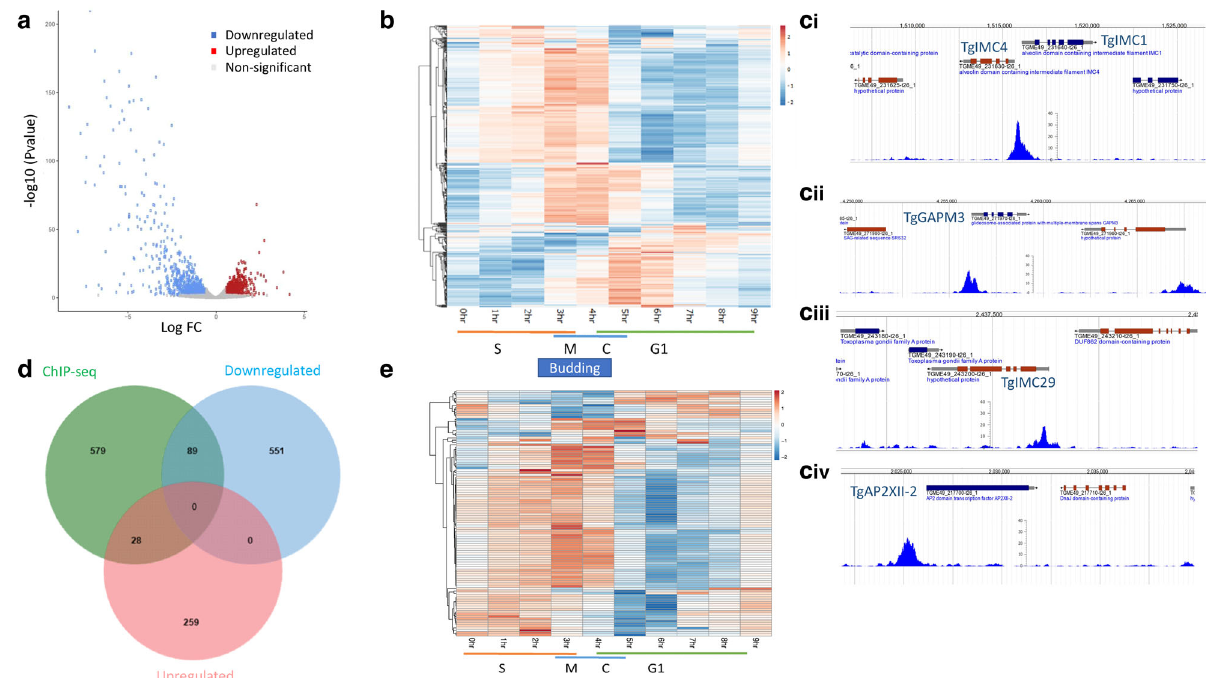
Fig. 5 TgAP2IX-5 controls the expression of key genes involved in daughter parasite formation. a Volcano plot of differentially expressed genes analyzed from RNA-sequencing of TgAP2IX-5 parasites treated with auxin for 6 h. Downregulated genes are represented in blue, upregulated genes are represented in red. Statistically nonsigni fi cant genes are represented in gray. The differential expression analysis (DE) was based on three independent biological experiments. b Heatmap showing the cell cycle expression of all individual transcripts that are downregulated in the iKD AP2IX-5 strain in the presence of 6 h of auxin treatment. The cell cycle phases are represented at the bottom as well as the timing when budding occurs. c ChIP-seq data representing the direct targeting of TgAP2IX-5 to the promoters of TgIMC4 (i), TgIMC1 (i), TgGAPM3 (ii), TgIMC29 (iii), and TgAP2XII-2 (iv) genes. MACS2 generated tracks are represented together with the annotated genes (top). d Venn diagram of overlapping downregulated genes, upregulated genes from RNA-seq, and identi fi ed promoters of genes directly interacting with TgAP2IX-5. DEseq2 and MACS2 software were used to analyze RNA-seq and ChIP-seq data, respectively. e Heatmap of 89 downregulated genes directly activated by TgAP2IX-5. The cell cycle phases are represented at the